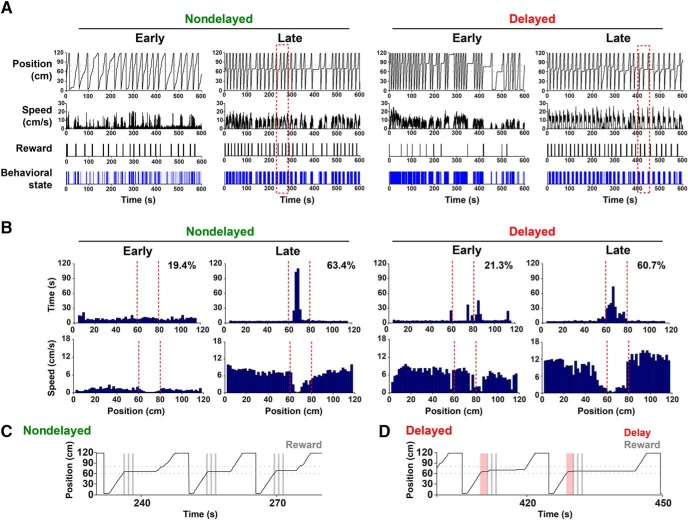
Behavioral changes induced by training. A, Examples of behavioral changes induced by training in the nondelayed (left) and delayed tasks (right). The data shown are collected from either one of the early or late sessions (i.e., the first or last 2-3 sessions) in each version of the task and from the same mouse. The behavioral parameters presented are (from top to bottom) mouse position in the virtual linear track (position), running speed (speed), timing of reward delivery (reward), and behavioral state. Behavioral state indicates whether the mouse was running or immobile, and periods of running, during which the running speed of the mouse ≧2 cm/s, are indicated by blue vertical bars. B, Histograms showing dwell time at each position on the track (upper panels) and average running speed across trials (lower panels) in early and late sessions of the nondelayed (left) and delayed tasks (right). The boundaries of the target zone are indicated by red dotted lines. Target periods are indicated in the upper right corner of the time histograms. C, D, Different sequences of behavior observed in the nondelayed (C) and delayed tasks (D). The areas of data enclosed by red dotted lines in A are shown at higher magnification. The shaded gray and red bars indicate the timing of reward delivery (reward) and waiting (delay), respectively.